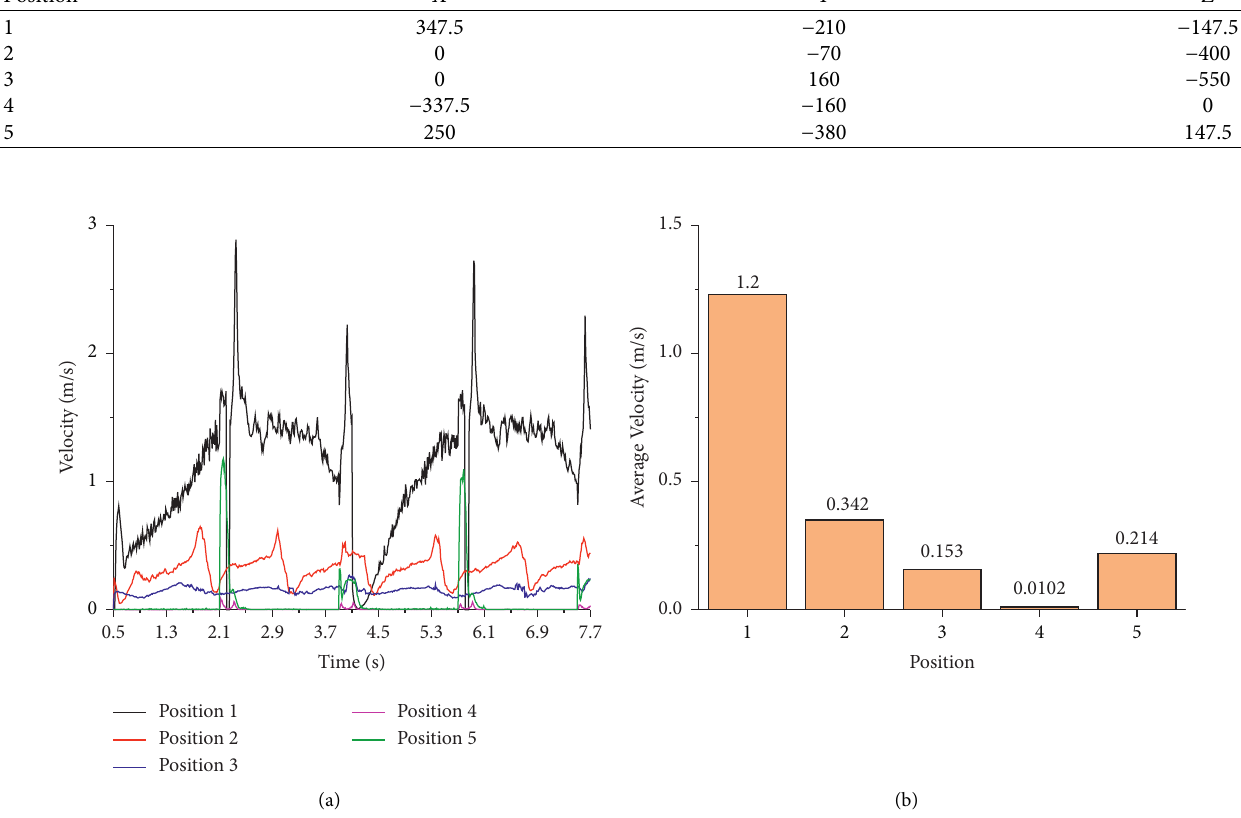
Figure 15: The change of particle velocity with time (a) and the average particle velocity at different locations